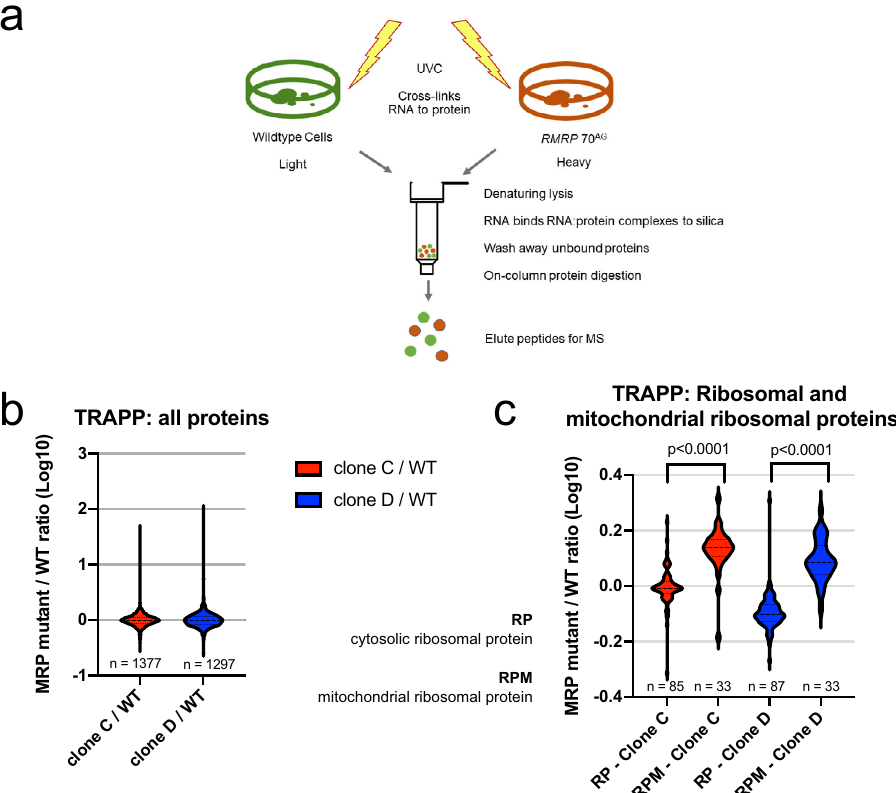
Fig. 4 70 AG mutation in RMRP results in a reduced ratio of cytosolic to mitochondrial ribosomes. a Overview of TRAPP technique. Wildtype and RMRP 70 AG cells were grown in heavy or light SILAC media, respectively, and UV crosslinked to stabilize RNA:protein interactions. Cells were lysed in denaturing conditions, and RNA:protein complexes bound to a silica column. Nonbound proteins were washed away, and remaining proteins digested on the column. Peptides were eluted for mass spectrometry. b Log-transformed SILAC ratios (70 AG mutant/wildtype) for all proteins quanti fi ed in TRAPP. c Log- transformed SILAC ratios for cytosolic ribosome proteins (RP) and mitochondrial ribosome proteins (RPM) obtained in TRAPP. Data shown in b and c are representative of two independent experiments, each including two SILAC mixes with different CRISPR clones. Violin plots depict distribution of SILAC ratios, with lines at median and quartiles. Indicated p values derived from two-tailed t tests: for clone C, t = 9.458, df = 116; for clone D, t = 13.62, df = 118. Source data are provided as a Source Data fi